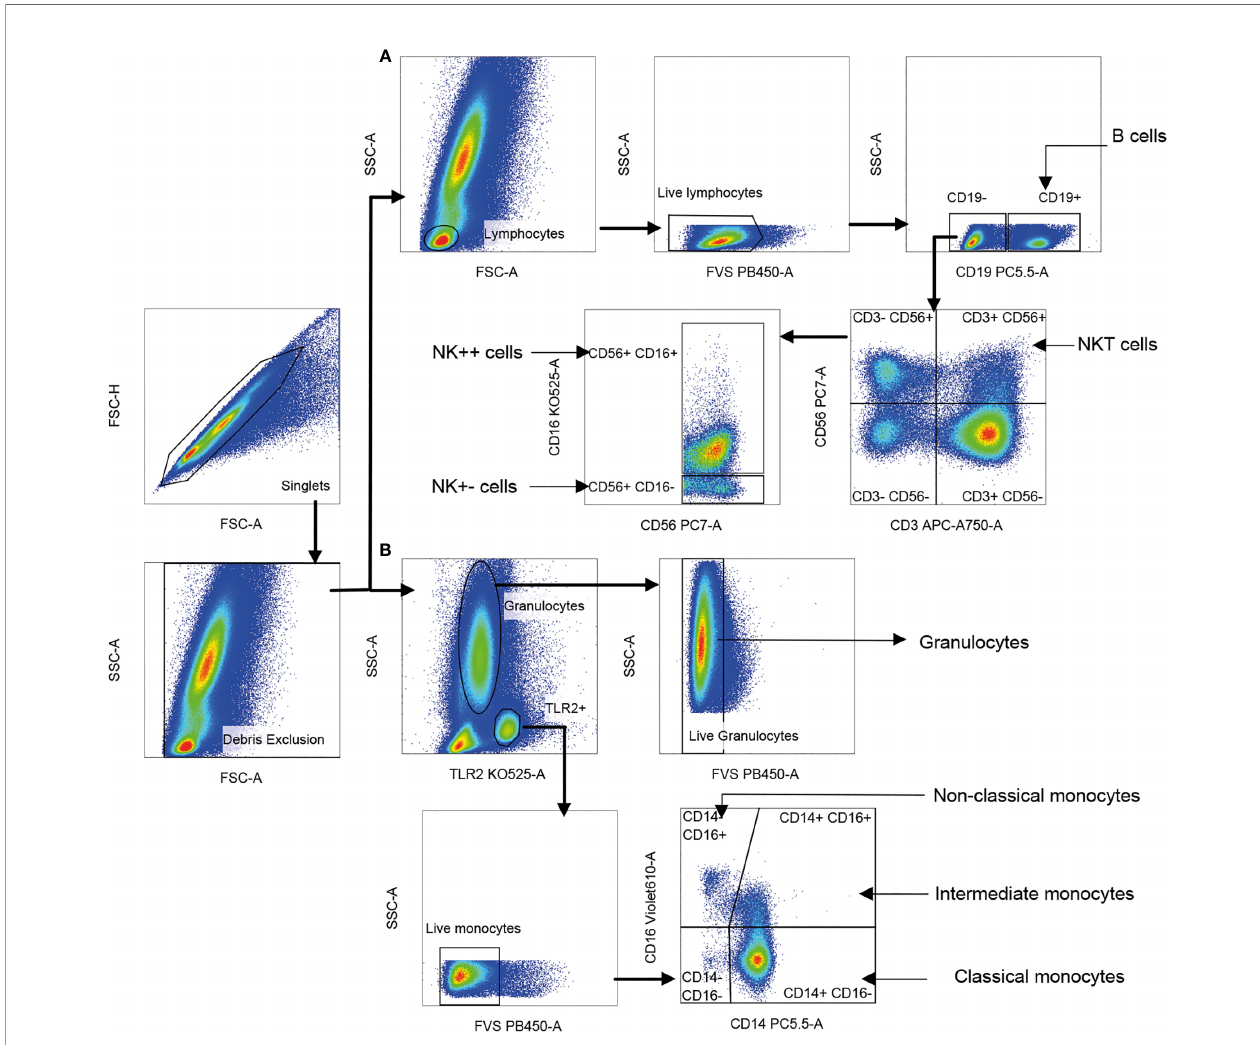
FIGURE 2 | Gating strategy for innate immune cell subsets. Singlet cells were selected based on FSC-A and FSC-H scatter, and debris was excluded based on FSC-A and SSC-A. (A) Lymphocytes were gated using FSC-A and SSC-A scatter; dead cells and B cells staining for live/dead dye and CD19, respectively were sequentially excluded. Natural killer T (NKT) cells were identi fi ed as CD56 + CD3 + (CD56 vs . CD3). Two CD3-negative natural killer (NK) cell subsets were identi fi ed as CD56 + CD16 + (NK++) cells and CD56 + CD16 − (NK+ − ) cells displayed on CD56 vs . CD16. Cells positive for CD19 lineage marker were identi fi ed as B cells. (B) Live monocytes were identi fi ed as TLR-2 + and negative for live/dead dye. Three monocyte subsets were distinguished as CD14 + CD16 − classical monocytes, CD14 + CD16 + intermediate monocytes (IM) and CD14 − CD16 + non-classical monocytes (NCM) based on CD16 vs . CD14. Live granulocytes were distinguished based on SSC-A scatter vs . TLR-2 followed by those negative for live/dead